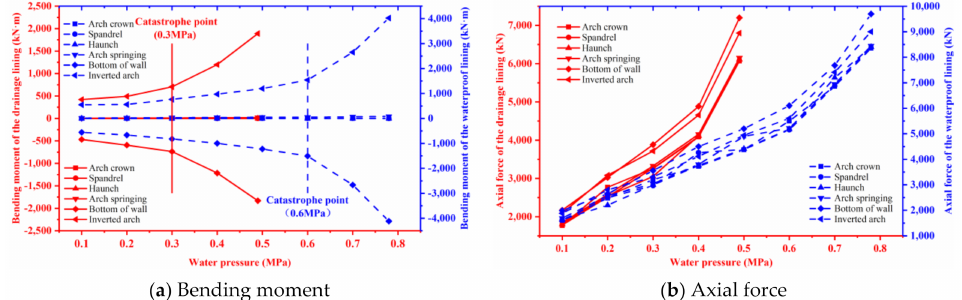
Figure 10. Relationship between the internal forces and the water pressure. The curves of the safety factor for key points of the drainage and waterproof lining structures under water pressure are presented in Figure 11. The following observations are